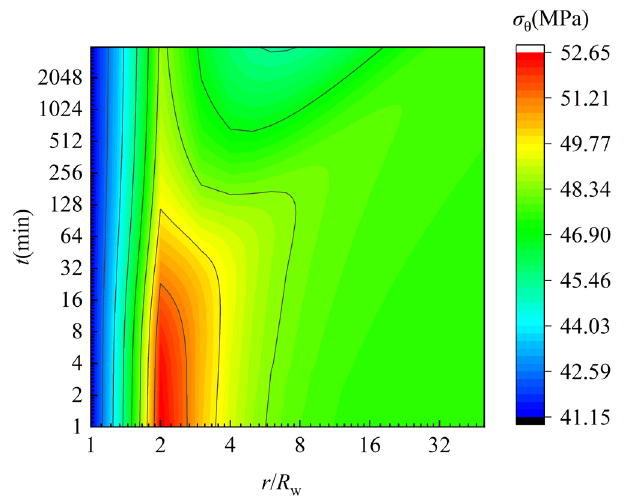
Figure 5. Distribution of formation tangential stress (Q = 0.5 m 3 /min).